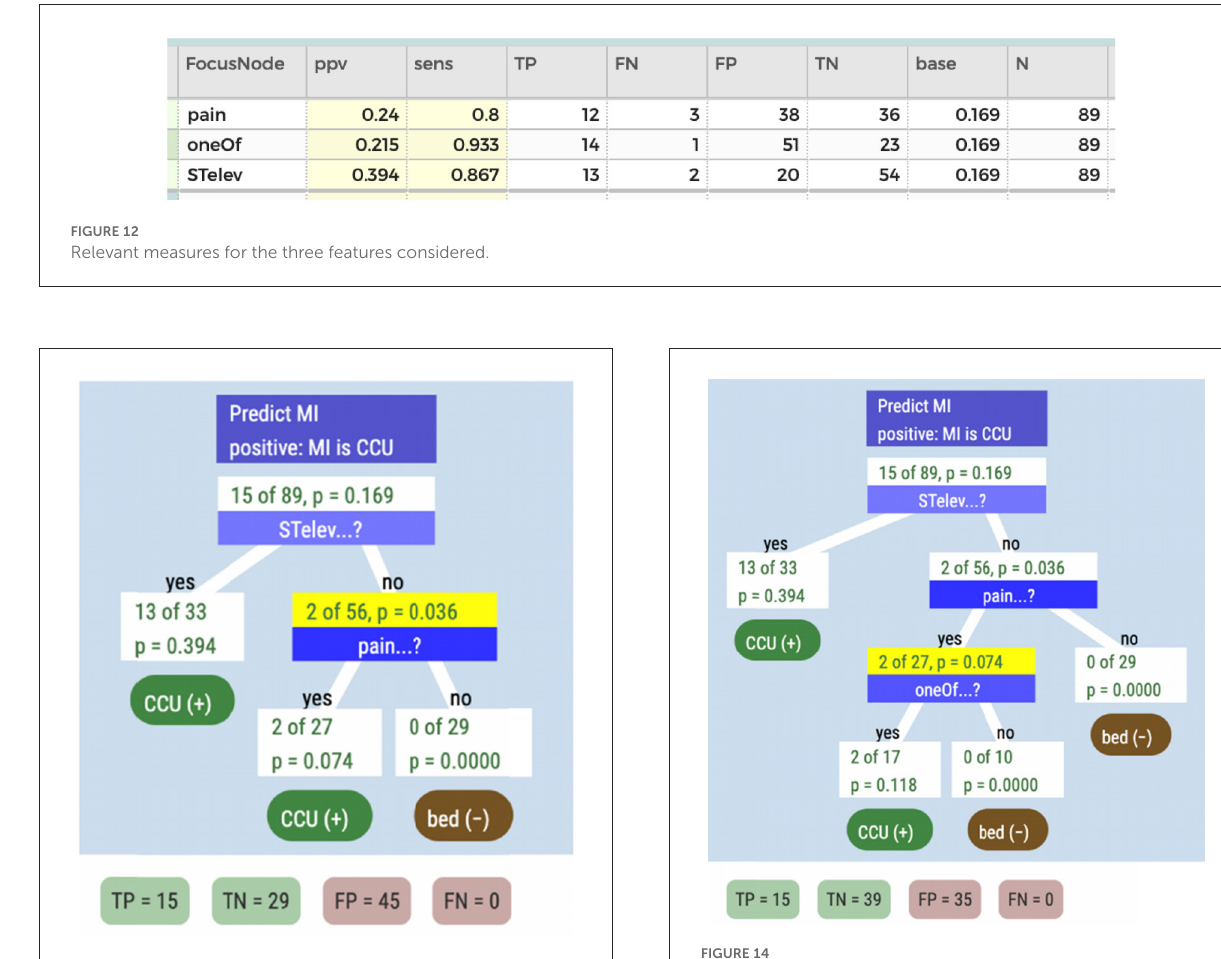
FIGURE13 The classification and decision tree with two features.